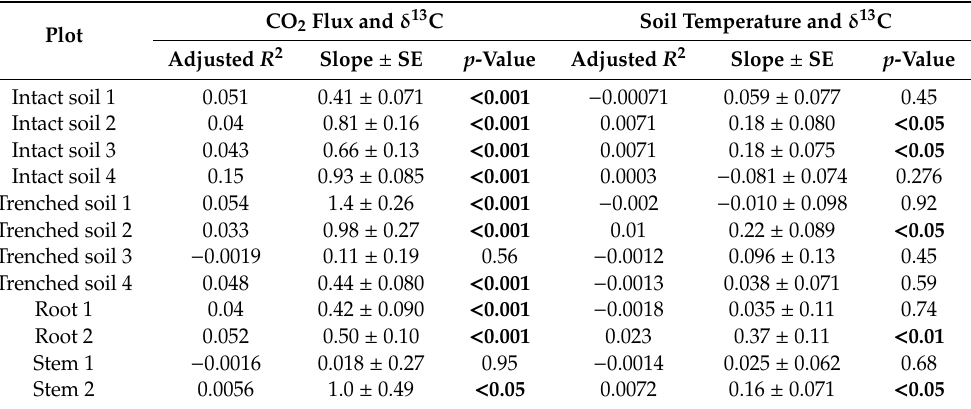
Table 2. Results of the linear regressions between the CO 2 fluxes and δ 13 C of the CO 2 fluxes and the linear regressions between the soil temperature at 5 cm depth and δ 13 C of the CO 2 fluxes for each plot. For each regression, the adjusted R 2 , slope and p -value are shown. A p -value in bold indicate a significant p